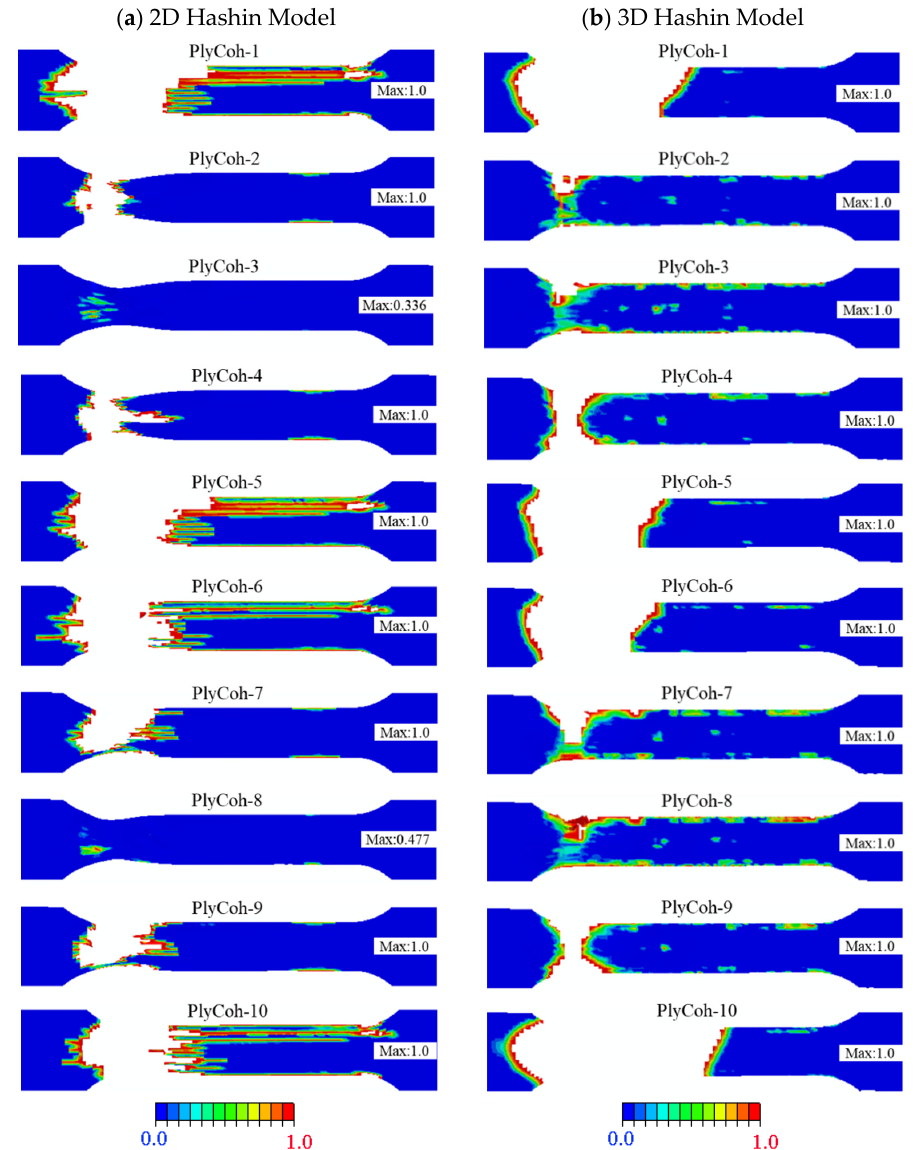
Figure 15. The final damage patterns of cohesive layers: ( a ) 2D Hashin model; ( b ) 3D Hashin